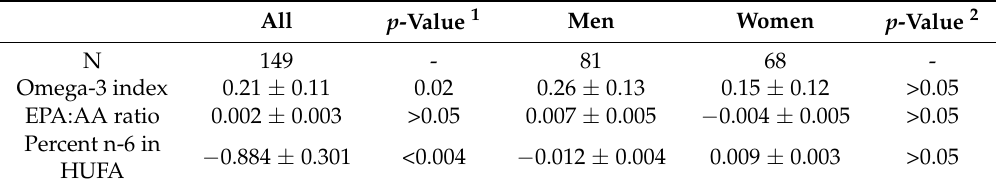
Table 5. Change in fatty acid status between baseline and second test for individuals undergoing two screenings 3 months